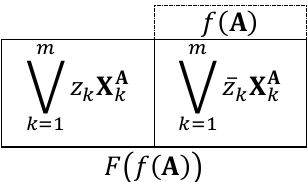
Figure 1. VKEM representation of the left-hand side of equation